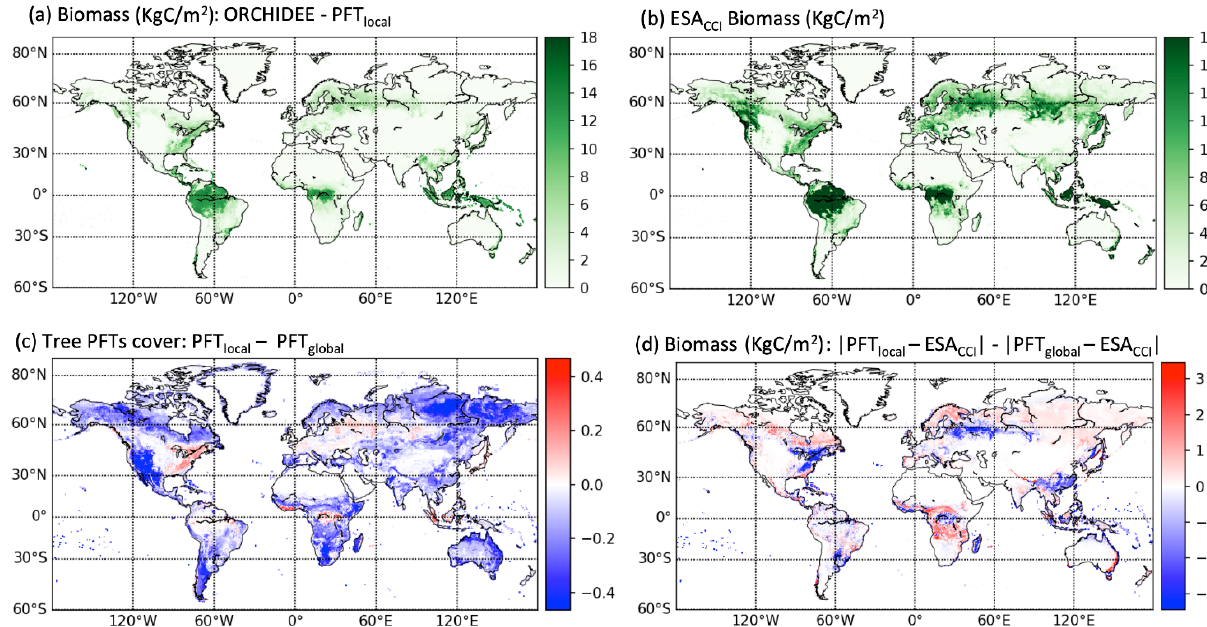
Figure 4. Above-ground biomass (AGB) (a) simulated by the ORCHIDEE model with the PFT local dataset and (b) observed by the ESA CCI Biomass product version v3, for the year 2010 (Santoro and Cartus, 2019). (c) Differences in the tree PFT fraction prescribed. (d) Difference between the mean bias of simulated vs. ESA CCI Biomass AGB between the new (PFT local ) and former (PFT global ) distributions of PFTs. Negative values indicate a decrease in the bias from PFT global to PFT local